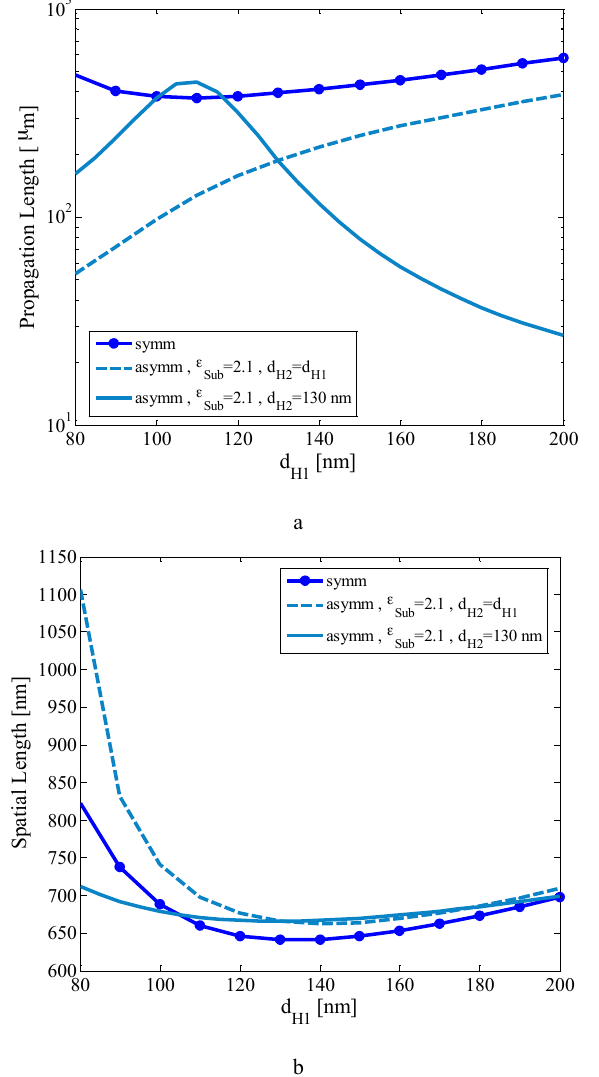
Figure 13: Comparing a. the propagation length and b. spatial length of HIMI slab waveguide in three cases of: 1. symmetrical, 2. asymmetrical a with silica substrate and 3. asymmetrical with silica substrate and asymmetry in H-layer thickness (d H2 =130 nm).